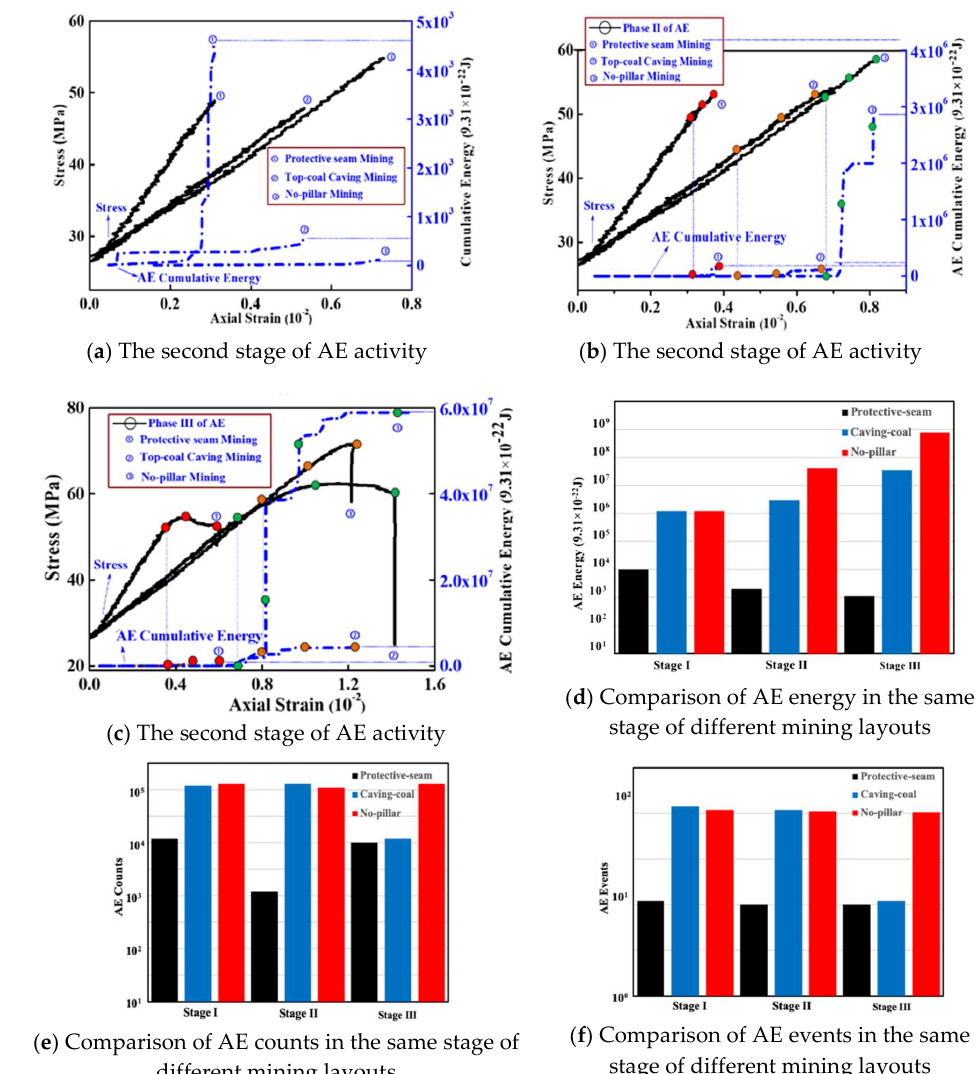
Figure 7. AE events, ring-down count, and energy under different mining layouts.